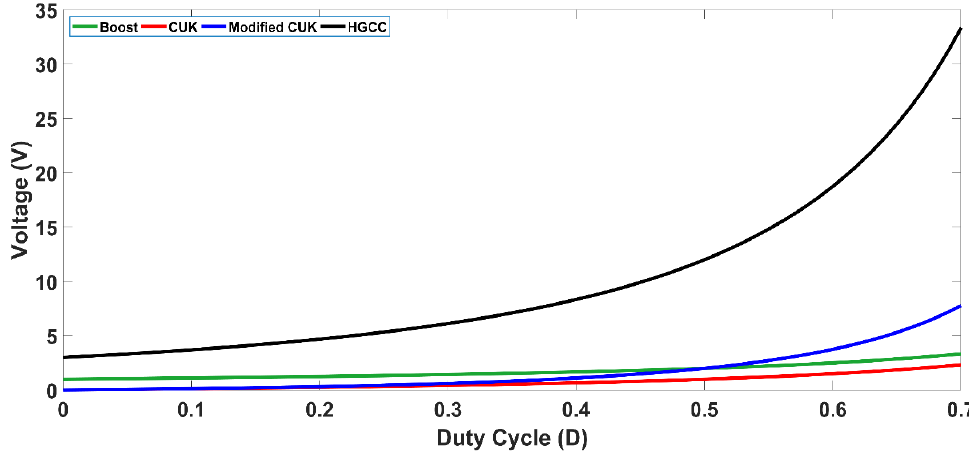
Figure 8. Output voltages at duty cycles D = 0.3, D = 0.5 and D = 0.7 and V in = 3V.